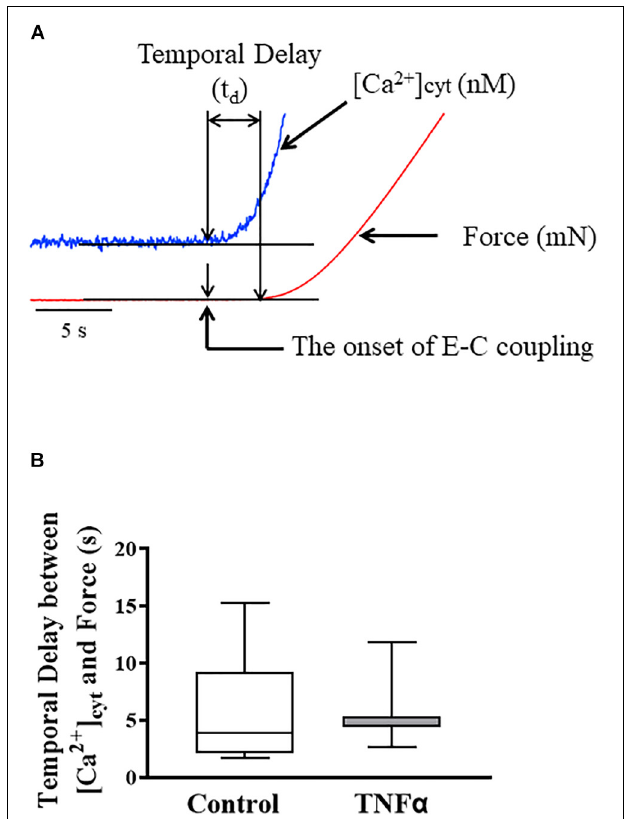
FIGURE 3 | Representative tracings of [Ca 2 + ] cyt (blue) and force (red) response of ASM to ACh stimulation (A) . The temporal delay (t d ) between the onset of [Ca 2 + ] cyt and force responses was not dependent on TNF α (B) . A one-way repeated measure ANOVA was used to analyze the results; p > 0.05, n = 6 (number of animals) and summarized as medians and interquartile range